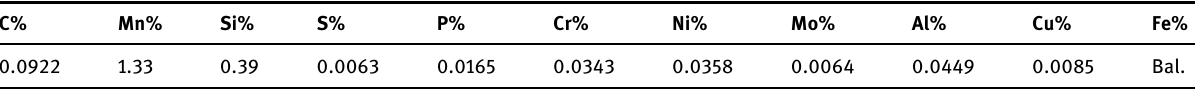
Table 1: The chemical composition of HSLA